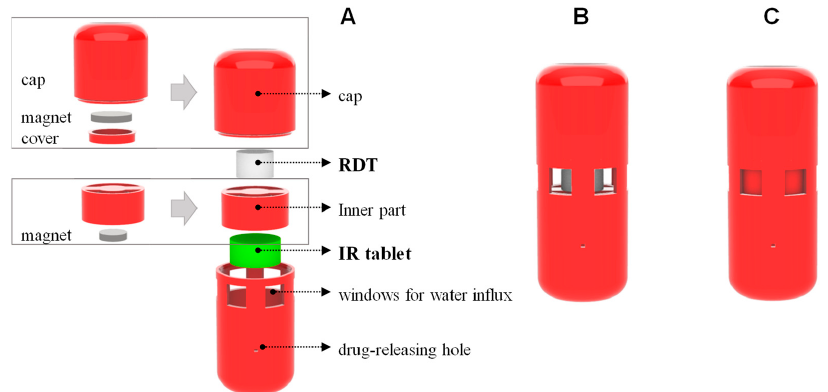
Figure 6. Structure of the 3d-printed gastroretentive sustained release drug delivery system that is composed of a cap with an air pocket inside and a body with windows for water influx and drug-releasing holes before assembly ( A ) and a final drug delivery system after assembly with the windows opened ( B ). After a rapidly dissolving tablet is dissolved, the windows for water influx are closed ( C ).